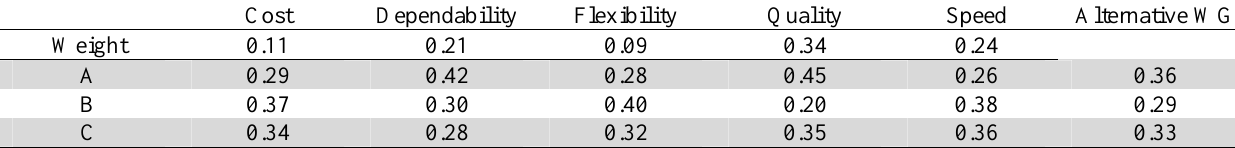
The summary of ranking